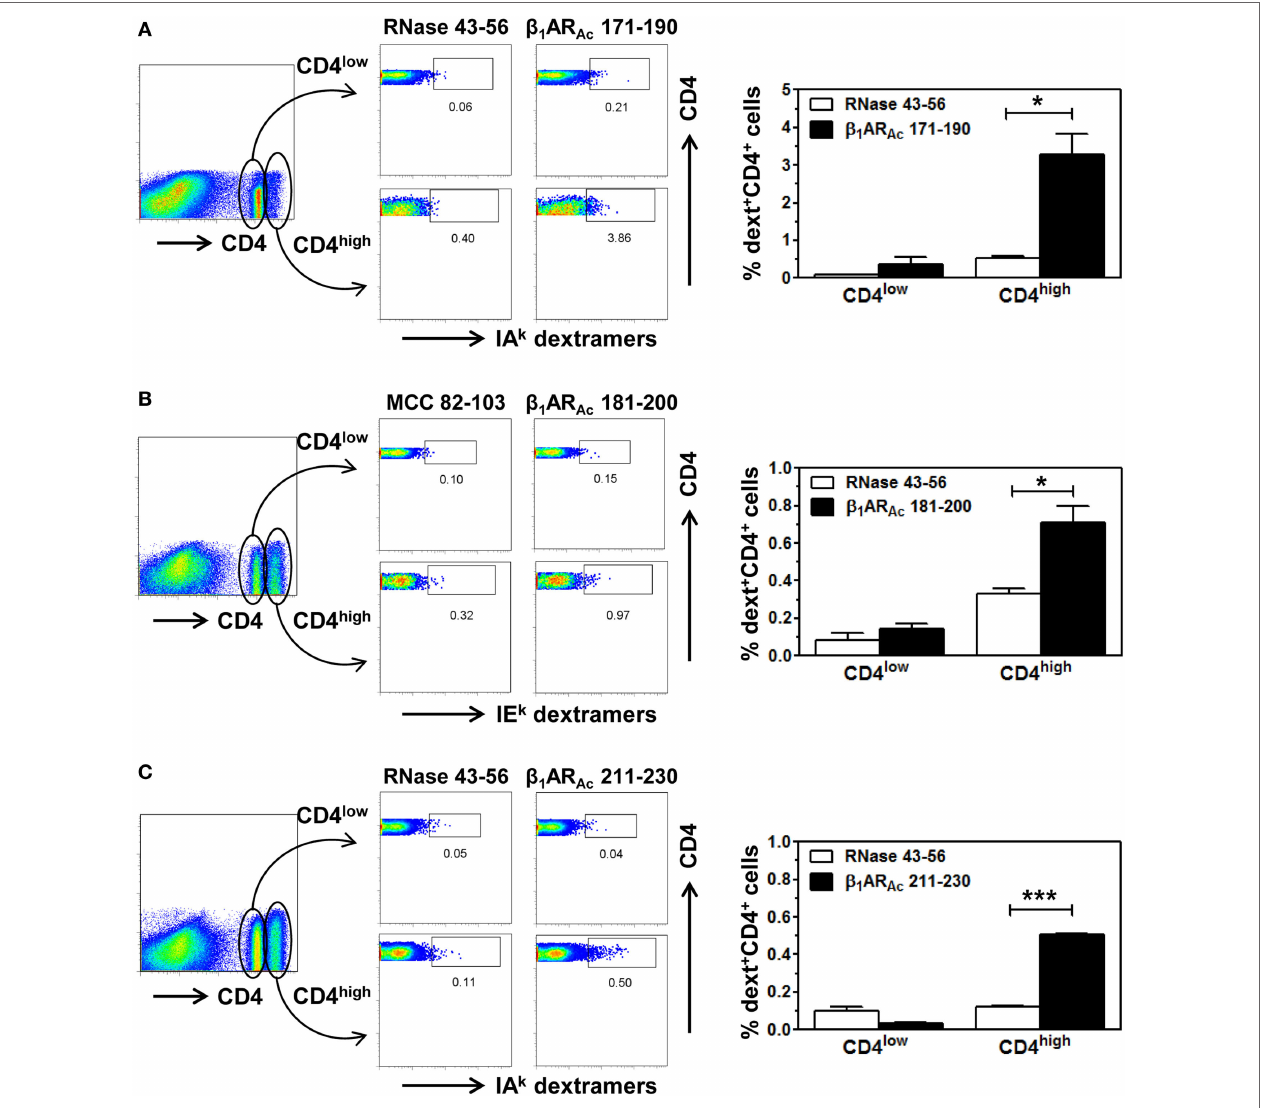
FigUre 4 | Antigen-specificity of T cell responses induced by β 1 AR Ac peptides. Lymph node cells (LNCs) or splenocytes prepared from animals immunized with β 1 AR Ac 171–190, β 1 AR Ac 181–200, and β 1 AR Ac 211–230 were restimulated with the corresponding peptides for 2 days and cells were rested in interleukin (IL)-2 medium. Cells harvested on days 7–10 poststimulation were stained with three sets of dextramers namely, IA k dextramers ( β 1 AR Ac 171–190 and RNase 43–56 as control), panel (a) ; IE k dextramers [ β 1 AR Ac 181–200 and moth cytochrome c (MCC) 82–103 as control], panel (B) ; and IA k dextramers ( β 1 AR Ac 211–230 with RNase 43–56 as control), panel (c) ; followed by staining with anti-CD4 and 7-aminoactinomycin-D (7-AAD). Cells were acquired by flow cytometry, and the dext + cells were analyzed corresponding to CD4 low or CD4 high populations using Flow Jo software (bar graphs on the right side in each panel). Representative flow cytometric plots are shown from two to three individual experiments, with two to five mice per group. * P < 0.05 and *** P < 0.001 vs. control